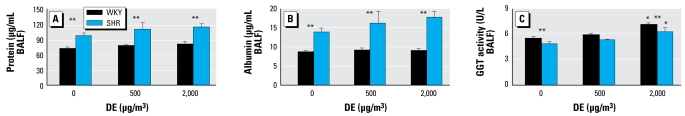
Pulmonary injury response to DE as determined by analysis of BALF levels of protein (A), albumin (B), and GGT activity in WKY and SH rats. Each bar represents the mean ± SE for nine animals.*Significant exposure effect. **Significant strain effect.